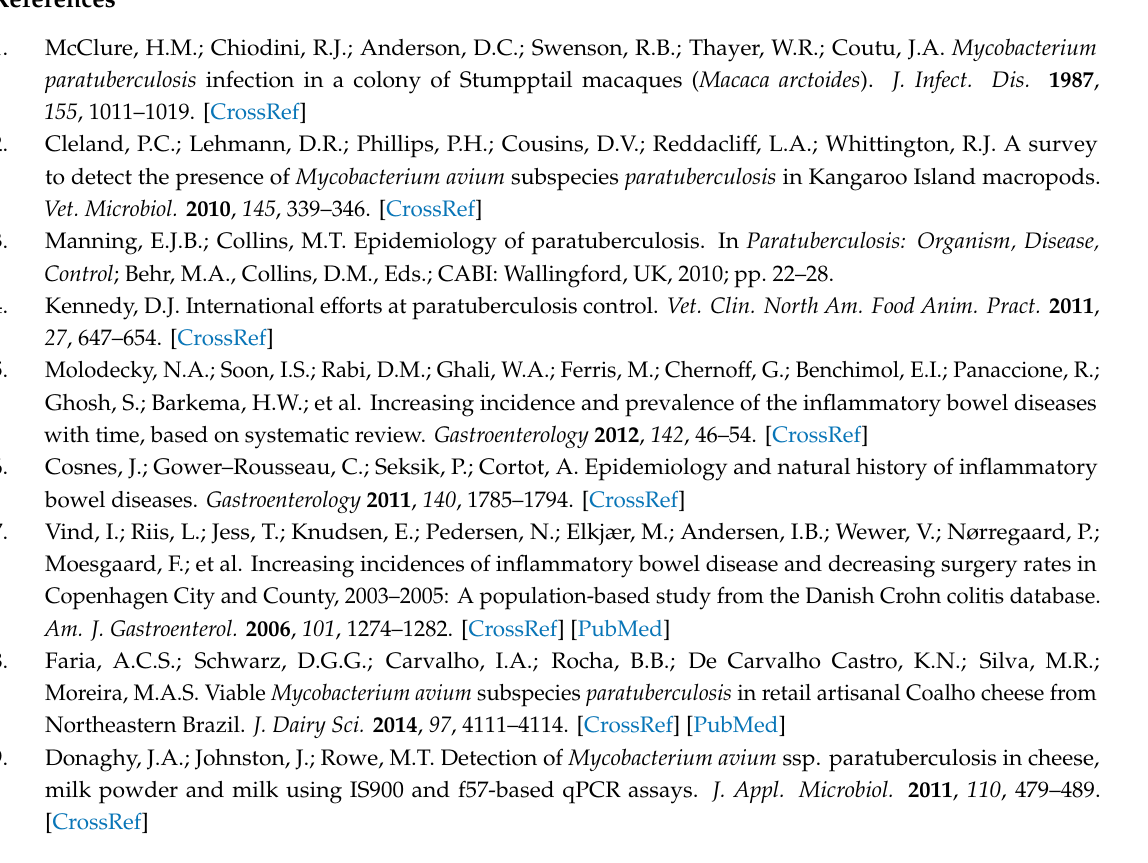
Table S1: Frequency table of categorical explanatory variables used in the analysis in the study conducted